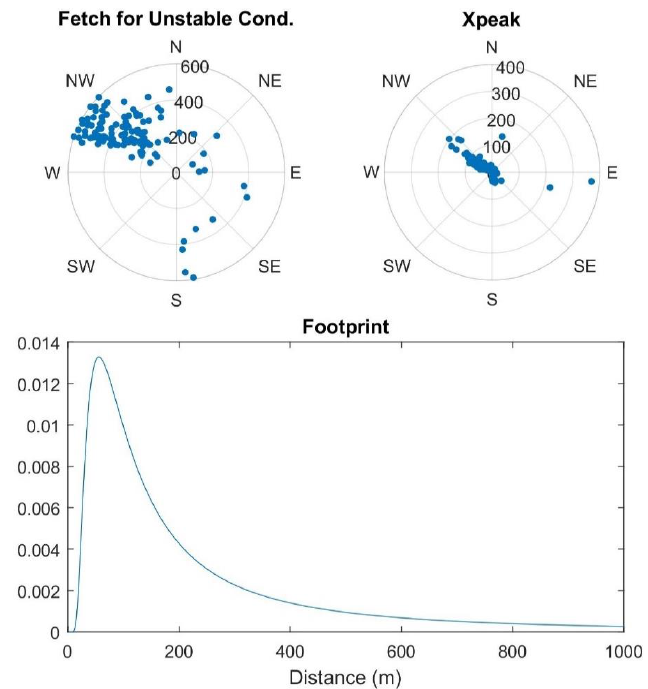
Figure 4. Footprint analysis, direction of the fluxes measured under unstable conditions, distance from the measurement point (Xpeak) and the footprint distribution function.